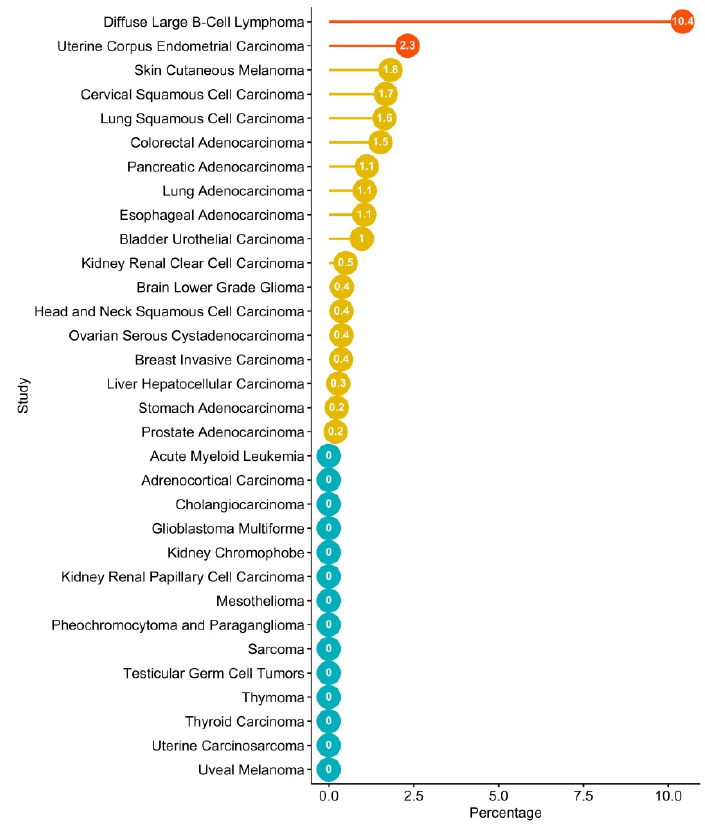
Figure 3. TCGA screening for frequency of CXCR4 mutations in tumors. TCGA patients’ mutations were investigated in cBioPortal [95], taking into consideration ones associated with CXCR4. Bar plot of frequency of CXCR4 expression in different tumors according to the TCGA dataset. Red and yellow dots refer to tumors that are statistically significant or non-significant, respectively, according to Fisher’s exact test. Blue dots refer to tumors where CXCR4 mutations are not identified. Plot was performed through Rstudio with ggplot2 [73] and ggpubr libraries [96] .